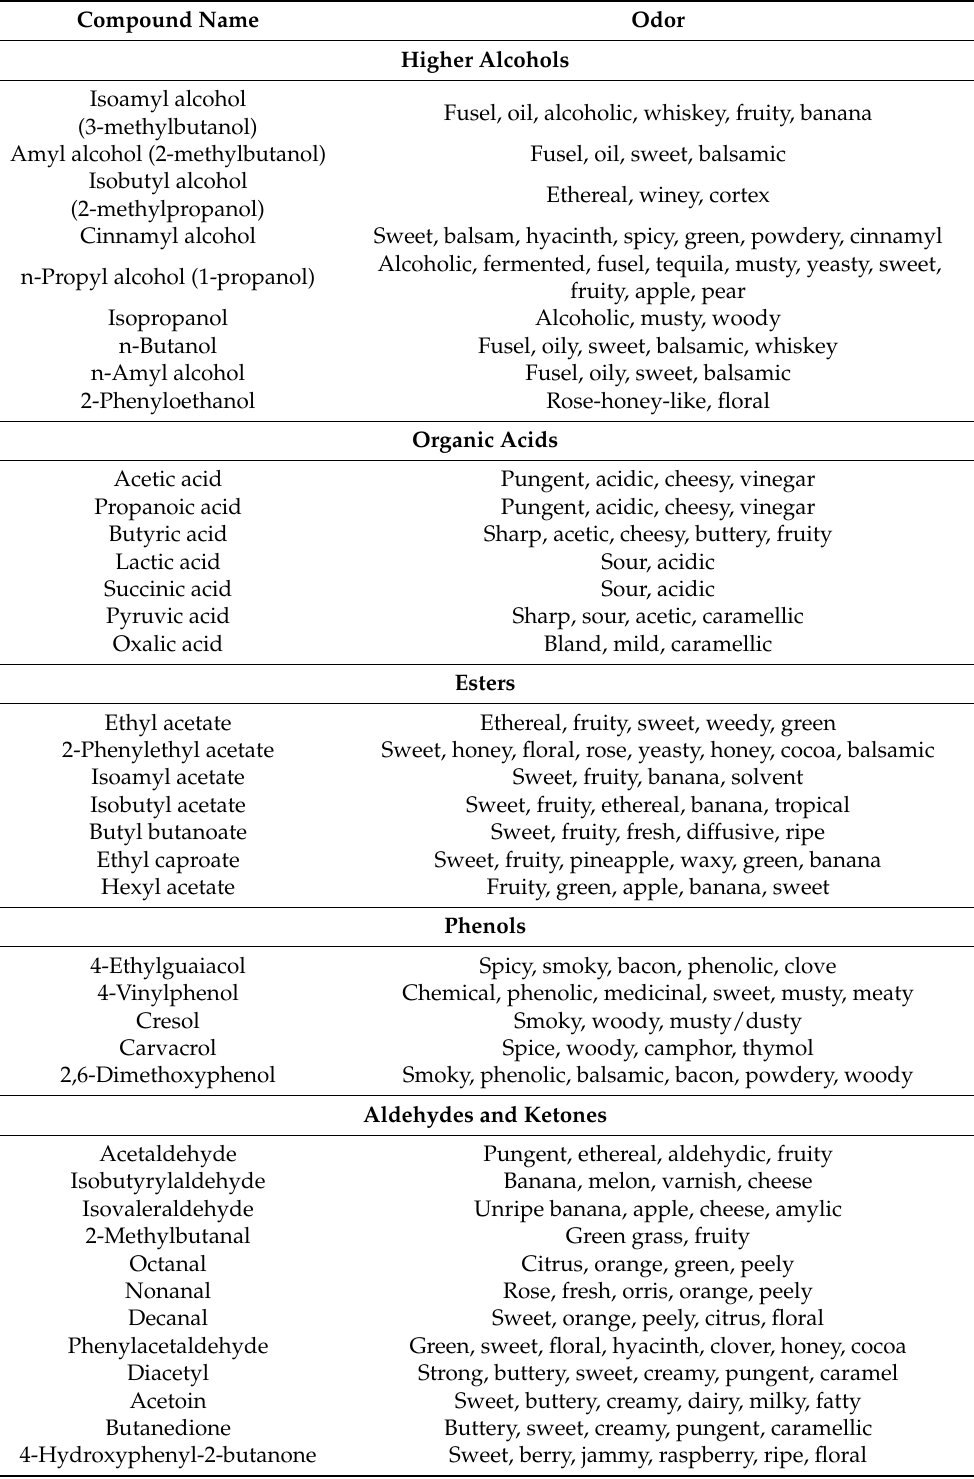
Table 2. Examples of volatile organic compounds present in food products